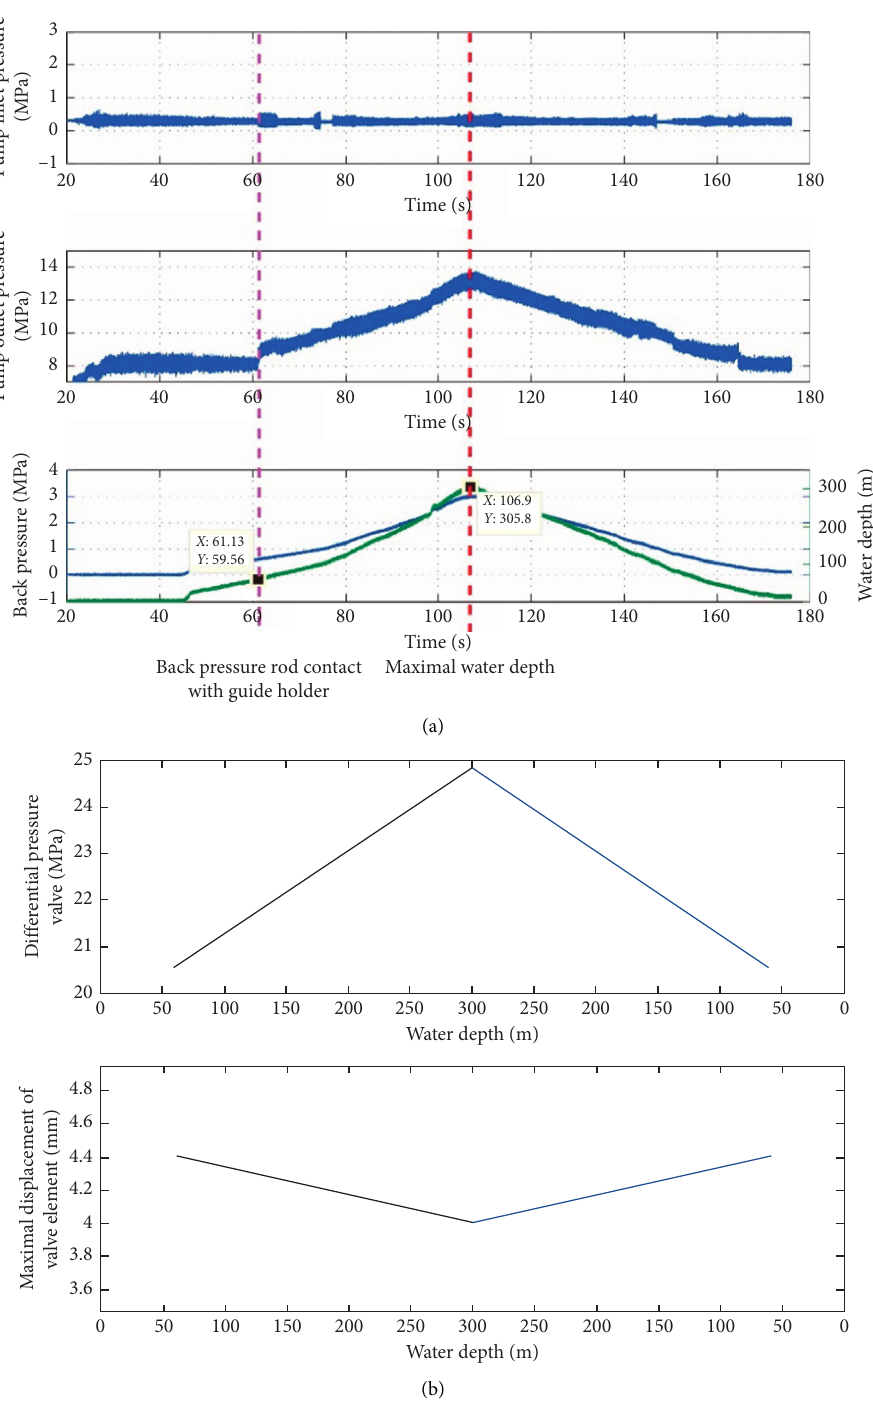
Figure 6: Experimental signal (a) and numerical simulation (b) for the case with inlet pressure of